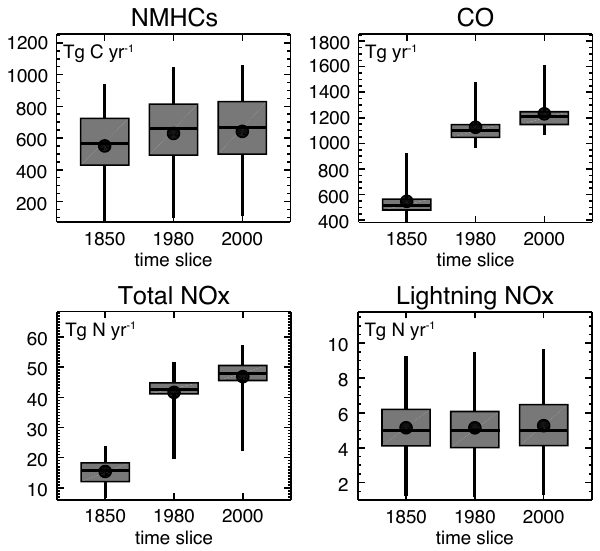
Fig. 3. Time evolution of historical total (anthropogenic+biomass burning+natural) emissions of NO x , CO and NMHCs. In addition, lightning emissions are shown. For each time slice, the filled circle indicates the mean, the solid line the median, the extent of the box is 25–75% and minimum and maximum are shown (adapted from Young et al., 2012).